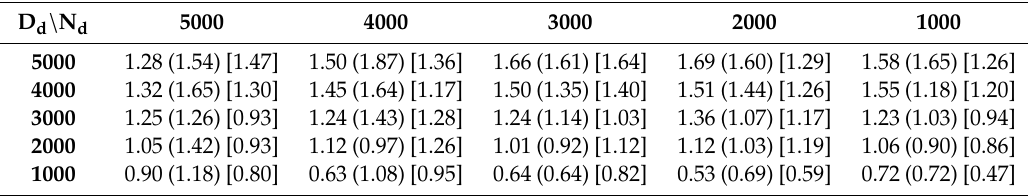
Table 3. Ratios of the NECI values for level ground walking with different admittance parameters with respect to the benchmark. The numbers without parentheses, with parentheses and with brackets are the results of Subject 1, Subject 2 and Subject 3, respectively.